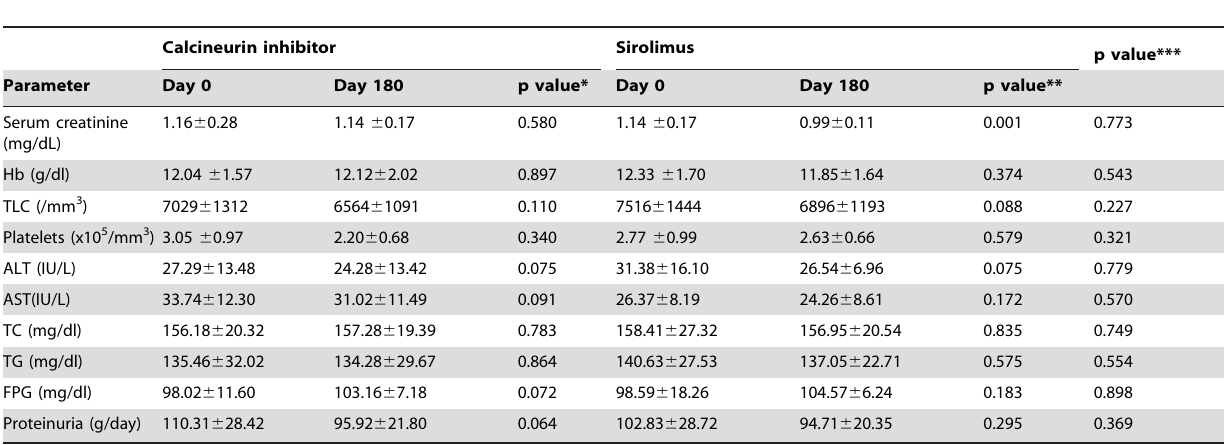
Table 3. Blood and urine chemistries in the two groups at baseline and at day 180.